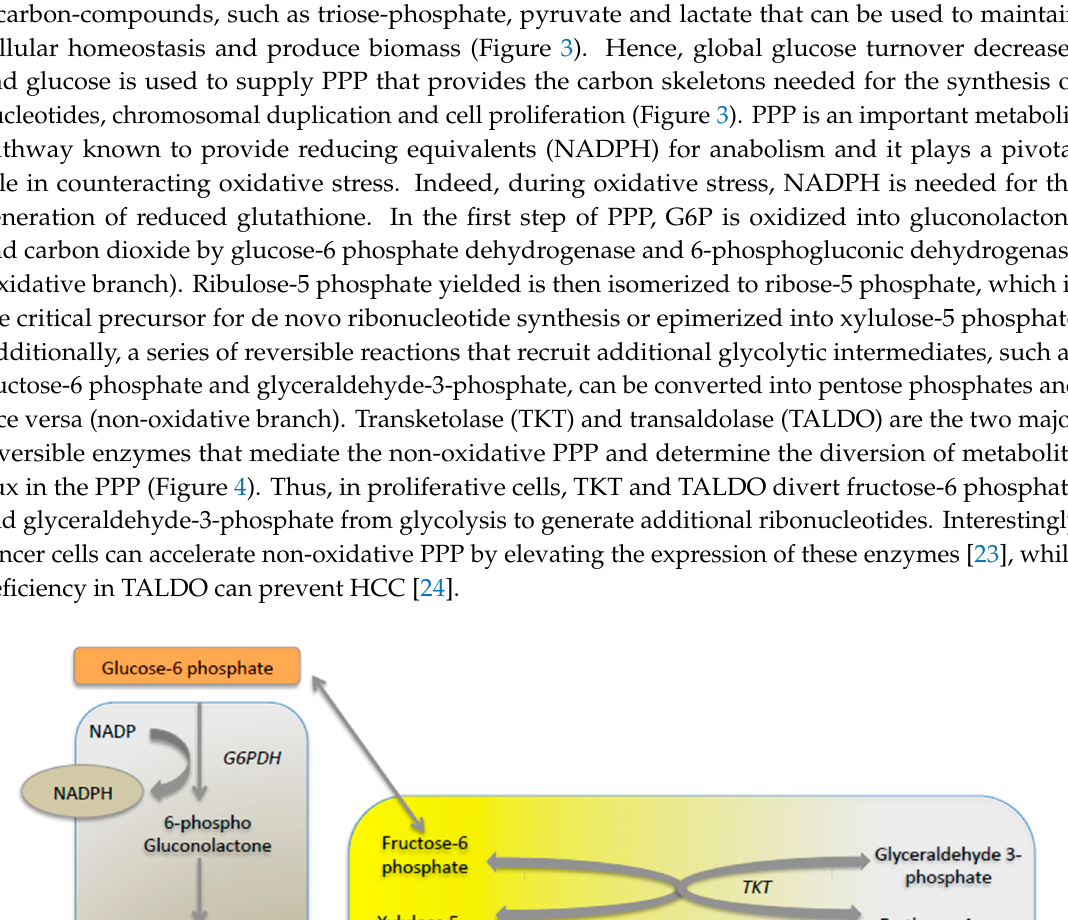
Figure 3. Glucose-6 phosphate: a source of energy and carbon skeletons. The G6P is metabolized either through the glycolytic pathway or PPP, which are tightly connected, depending on metabolic